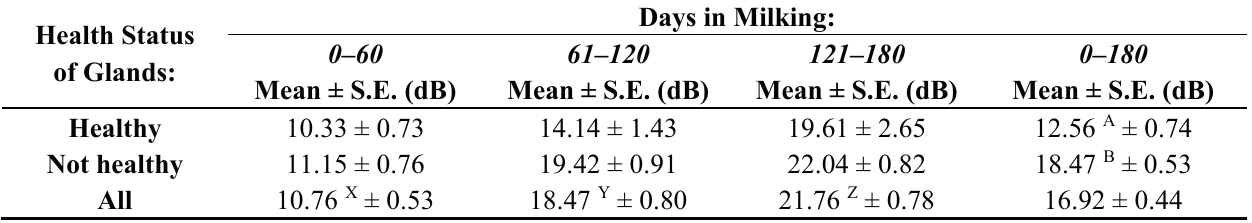
Table 9. Overall means and standard errors of the amplitude of peak FFT_P 2 , according to health status and lactation